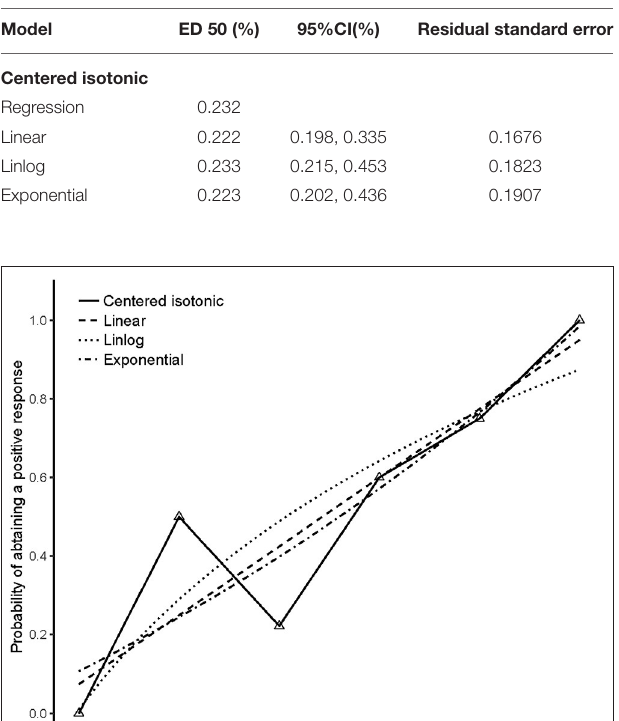
TABLE 2 | The mean effective concentration and 95% confidence interval of the different models.